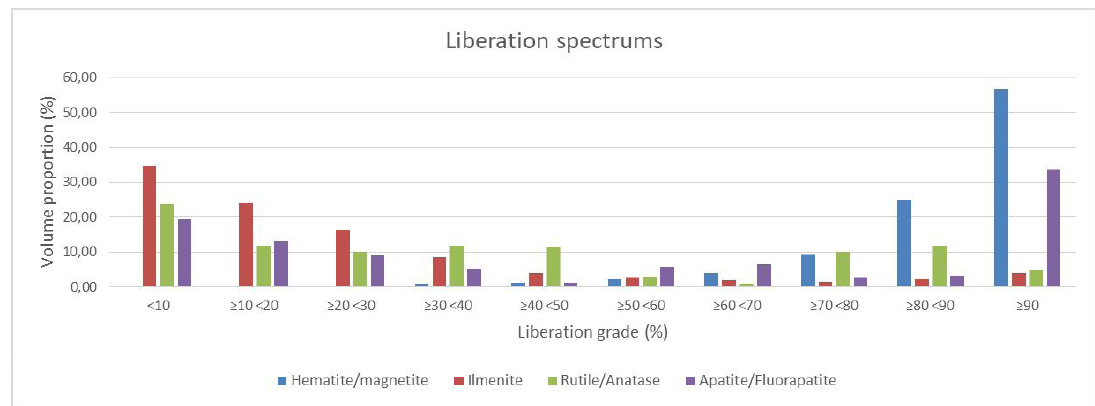
Figure 7. Volume liberation spectrum of the mineral phases of magnetic tailings obtained from phosphate-rock processing.